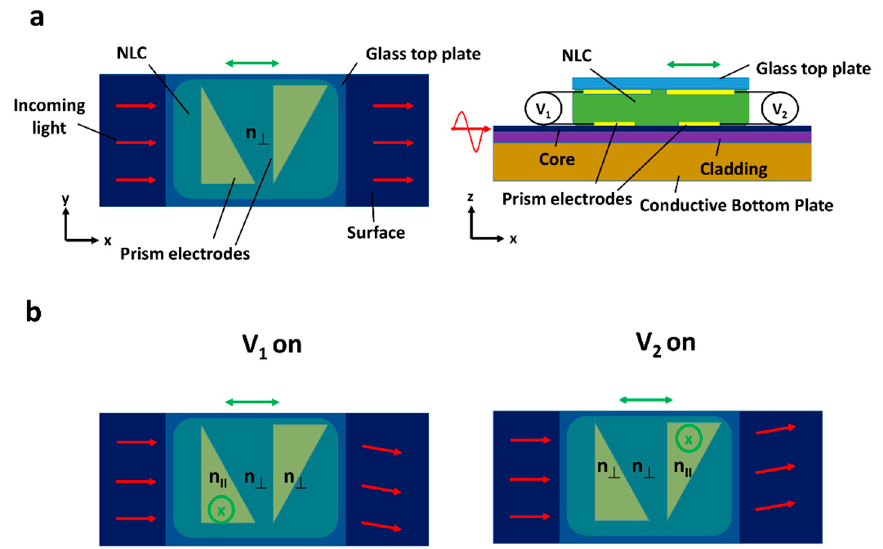
Figure 8. Shows an example of a liquid crystal waveguiding device. Here, light (red arrows) passes through the fibre core, and the produced evanescent wave interacts with the experienced refractive index of the LC in contact. This can be used to steer the ray as the LC can adopt a GRIN structure due to the electric field’s application. ( a ) Shows the device schematic with key features. ( b ) Shows its mode of operation, where the two voltages can be used for deflection to different directions.